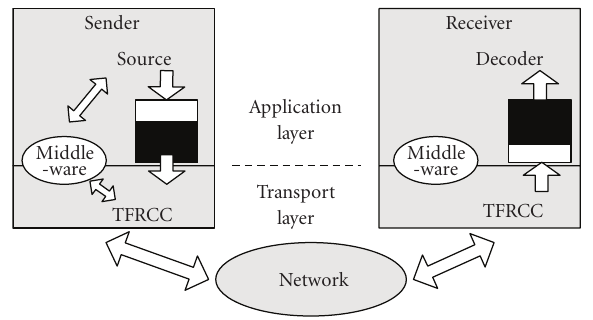
Figure 1: The system